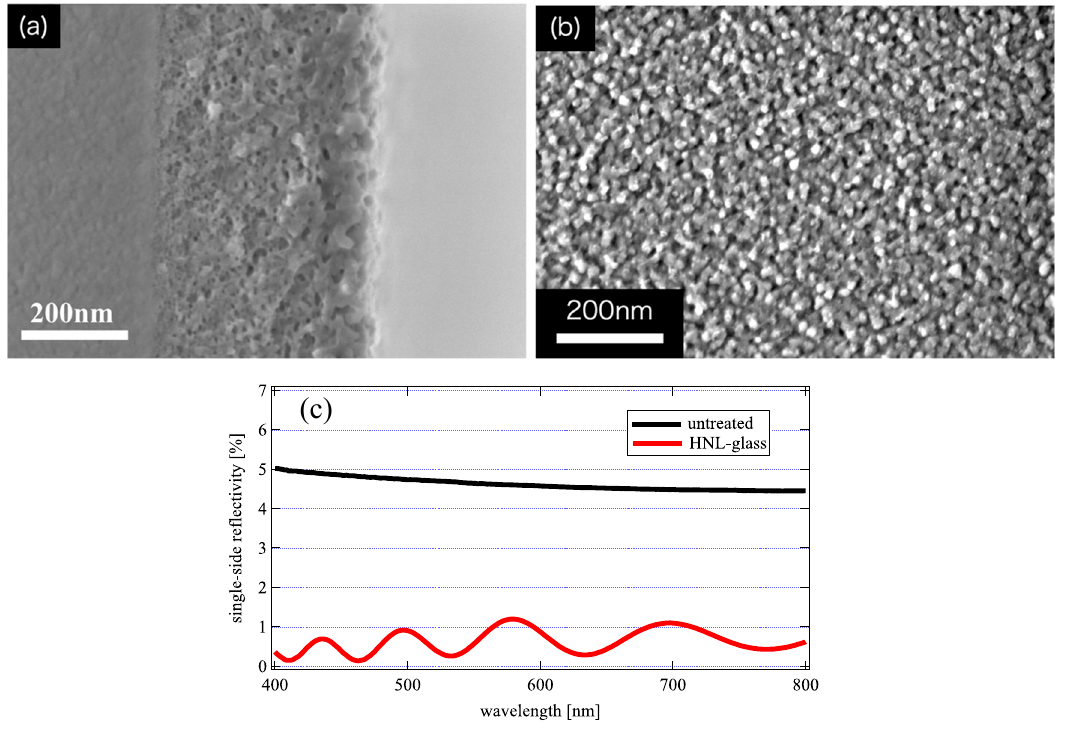
Figure 1. The HNL characterization. ( a ) Cross-sectional view and ( b ) surface view of the HNL in SEM micrography. Both micrographs were obtained without any metal deposition. ( c ) Single-side reflectivity spectrum of HNL and untreated glass.